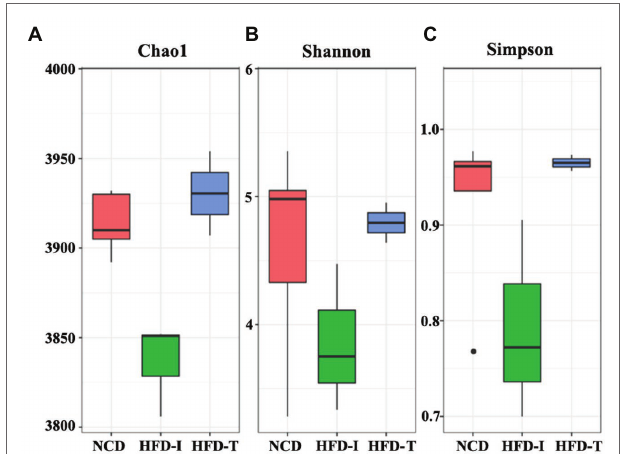
FIGURE 2 | Boxplots showing changes in alpha diversity of the gut microbiota in NCD, HFD-I, and HFD-T monkeys. Alpha diversity indices including Chao1 (A) , Shannon’s (B) index, and Simpson’s index (C) are